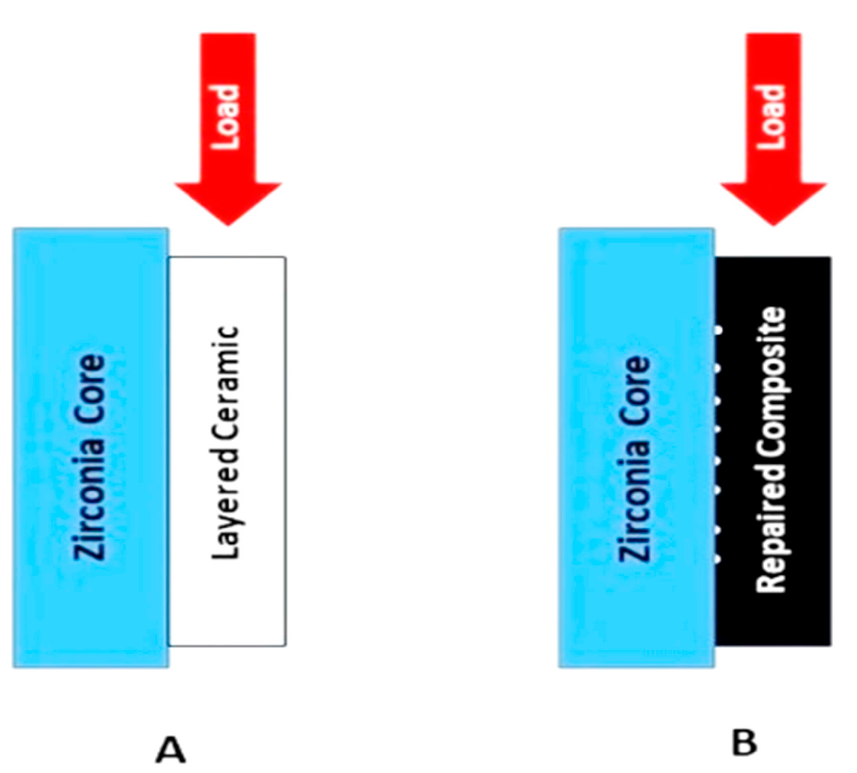
Figure 2. Diagrammatic representation of shear bond testing in universal testing machine; ( A ) zirconia core with ceramic; ( B ) zirconia core with repaired composite with some remnants of ceramic over the zirconia core. Table 2. Details of the repair procedures used for each of the five test groups.